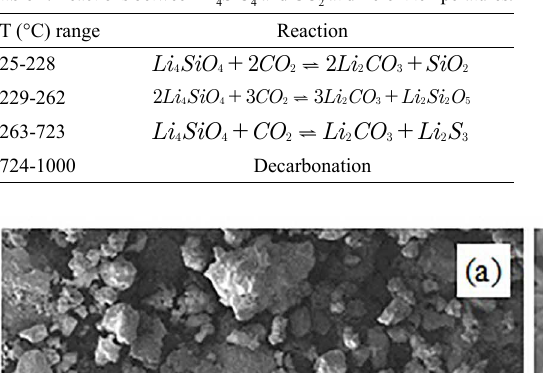
Table 1. Reactions between Li